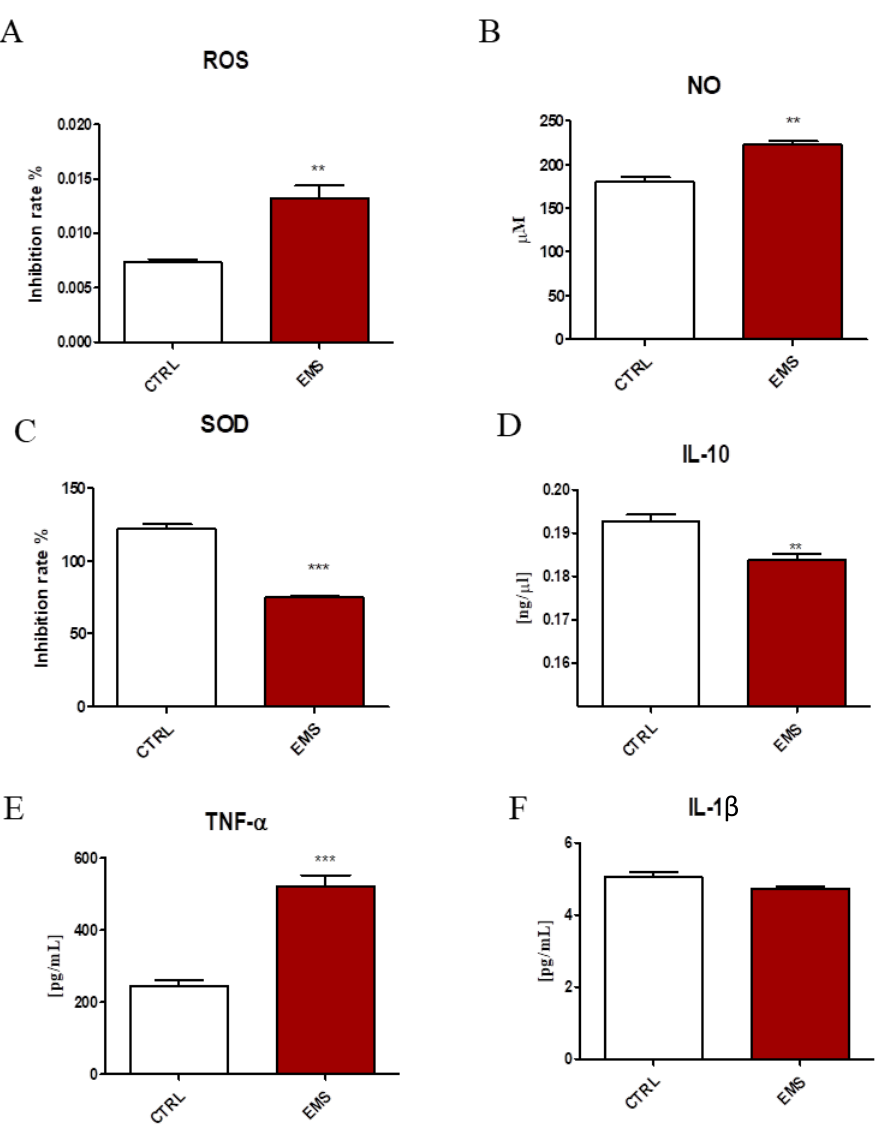
Figure 1. Oxidative stress and cytokines levels in the serum of healthy (CTRL) and EMS horses. Using commercially available, spectrophotometric assays, ROS ( A ), NO ( B ) and SOD ( C ) activity was assessed. The cytokine profile was evaluated with ELISA for IL-10 ( D ), TNF- α ( E ) and IL-1 β ( F ). Results expressed as the mean ± standard deviation (S.D.) ** p < 0.01, *** p <